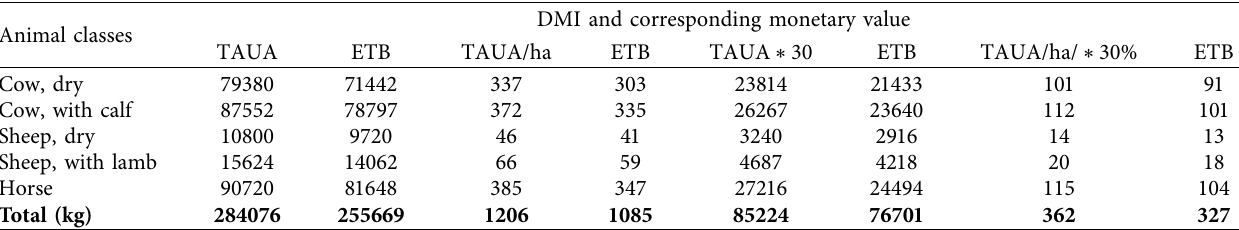
Table 8: Te monetary value of grass/fodder production from the Surra government plantation was priced according to the average price of grass/fodder in the local market.